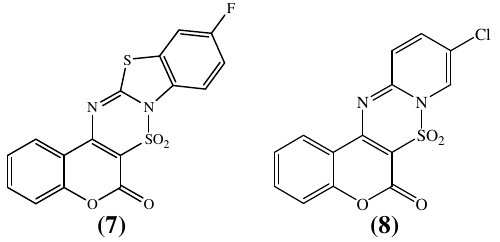
Figure 3. Structure of synthesized compounds (5-8)